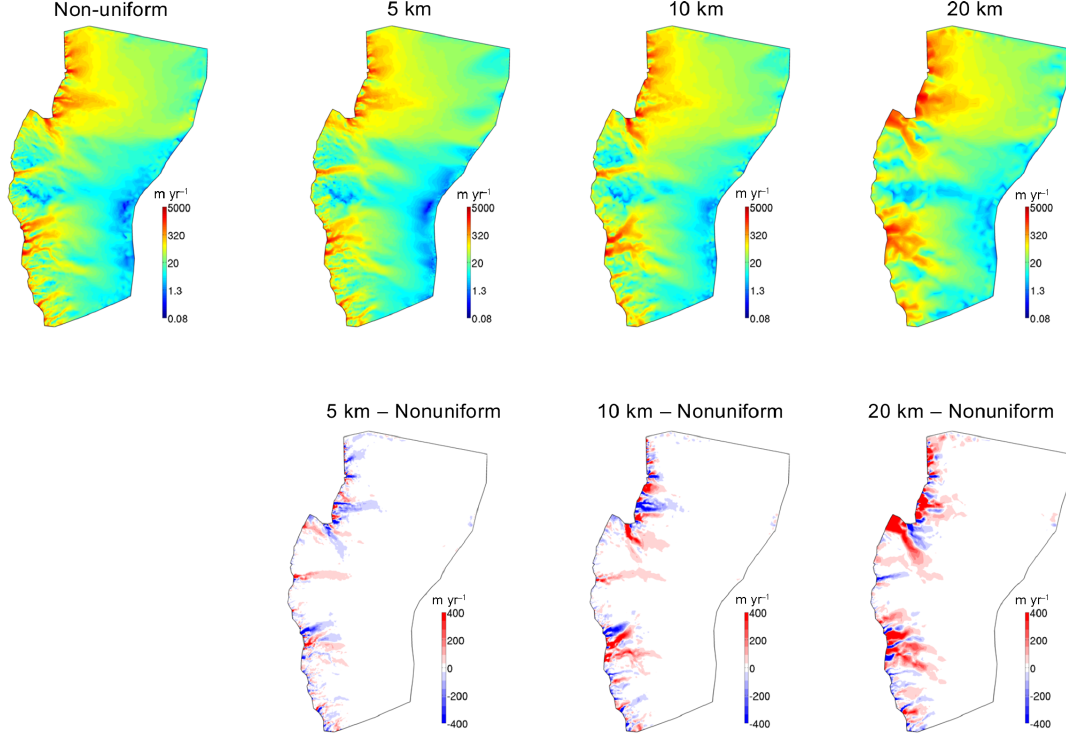
Figure 5. Relaxed ice surface velocities at 12ka for each model and differences from the nonuniform